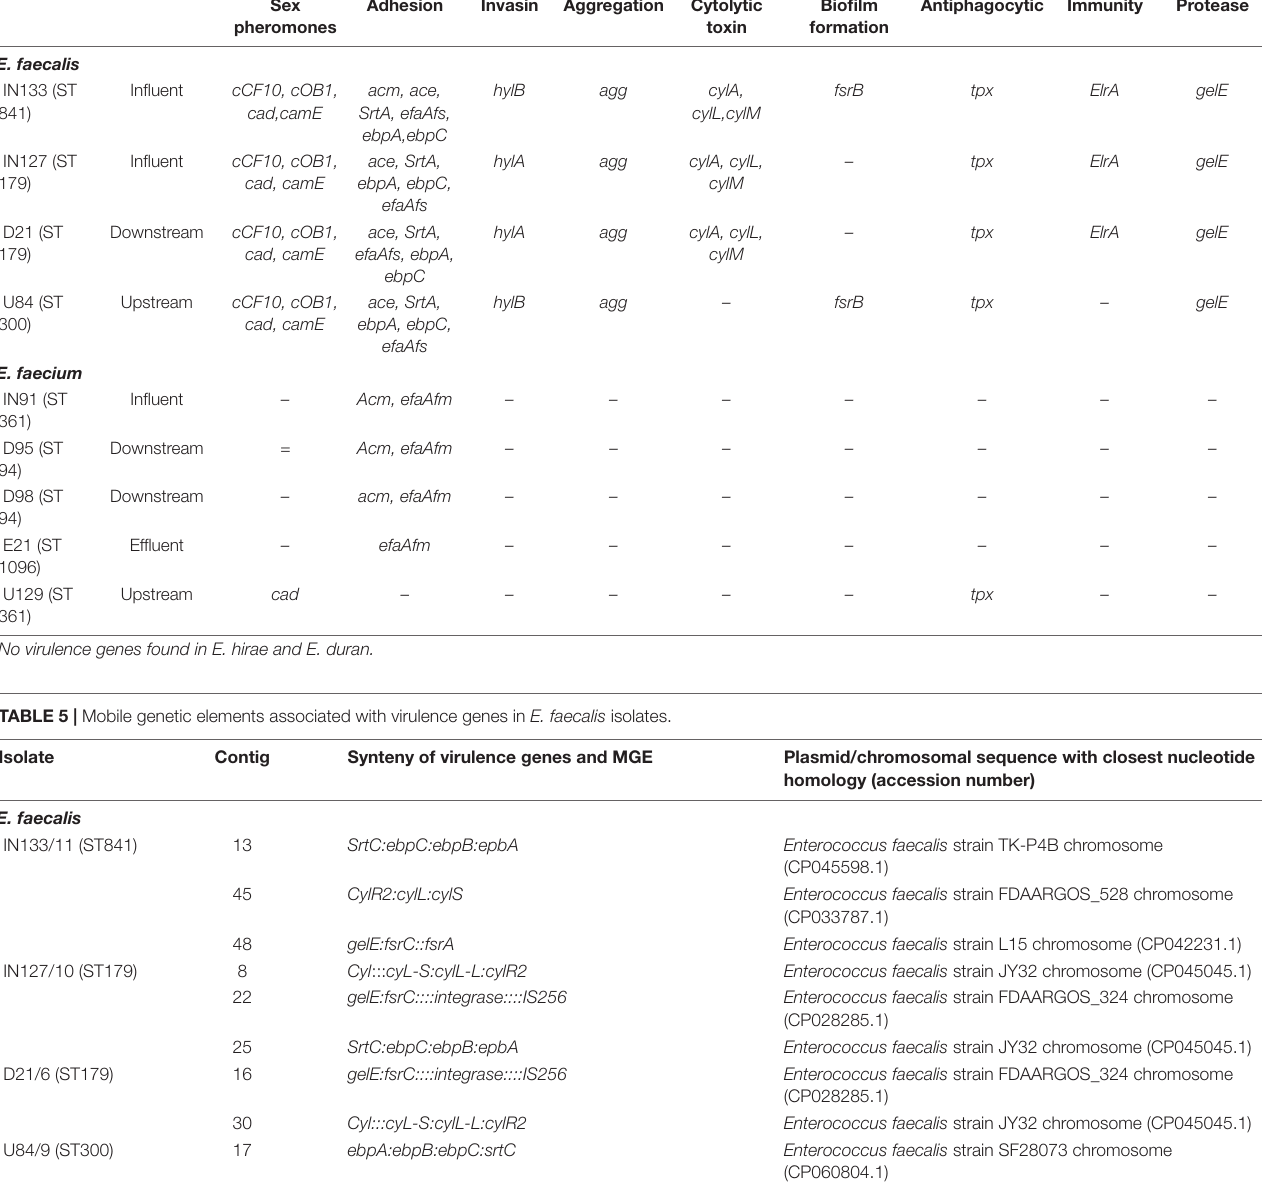
TABLE 4 | Virulence gene profiles of environmental Enterococcus spp.